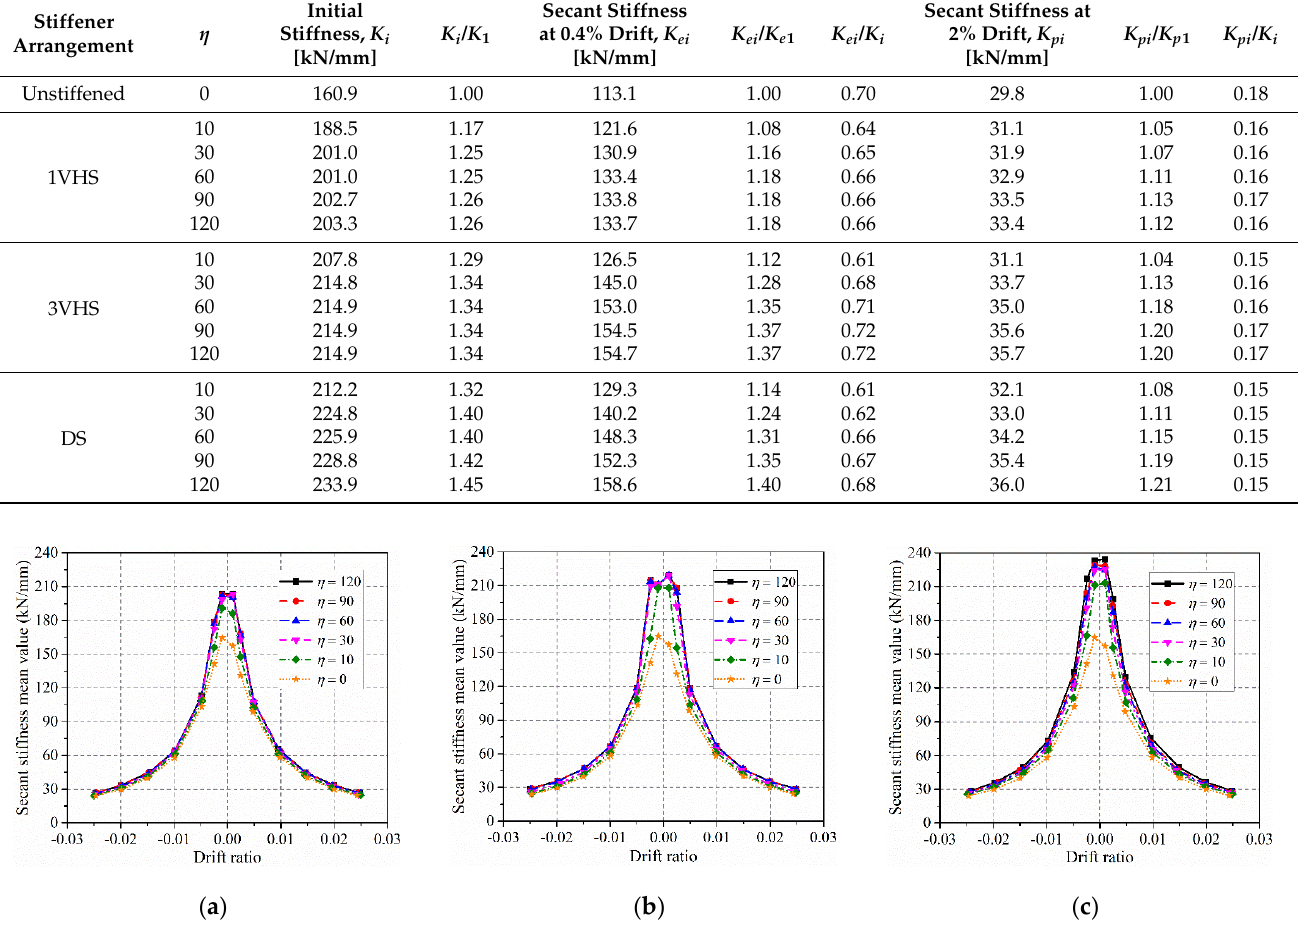
Figure 14. Secant stiffness reductions of: ( a ) SPSW1 − 1VHS, ( b ) SPSW1 − 3VHS, and ( c ) SPSW1 − DS with different η .